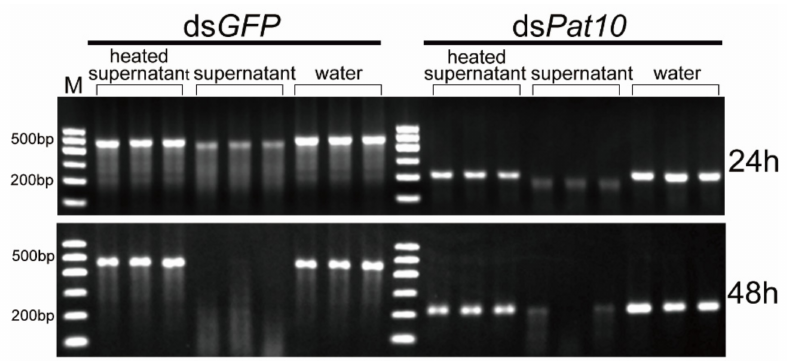
Figure 3. Agarose gel electrophoresis results of dsRNA and nematode secretions soaked for 24 and 48 h.